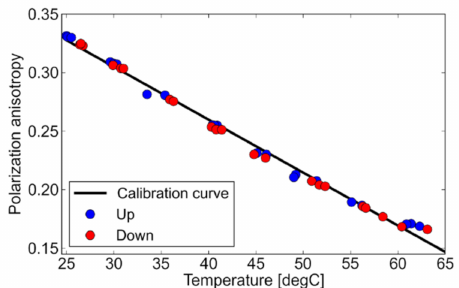
Figure 5. Fluorescence anisotropy of fluorescein solution as a function of